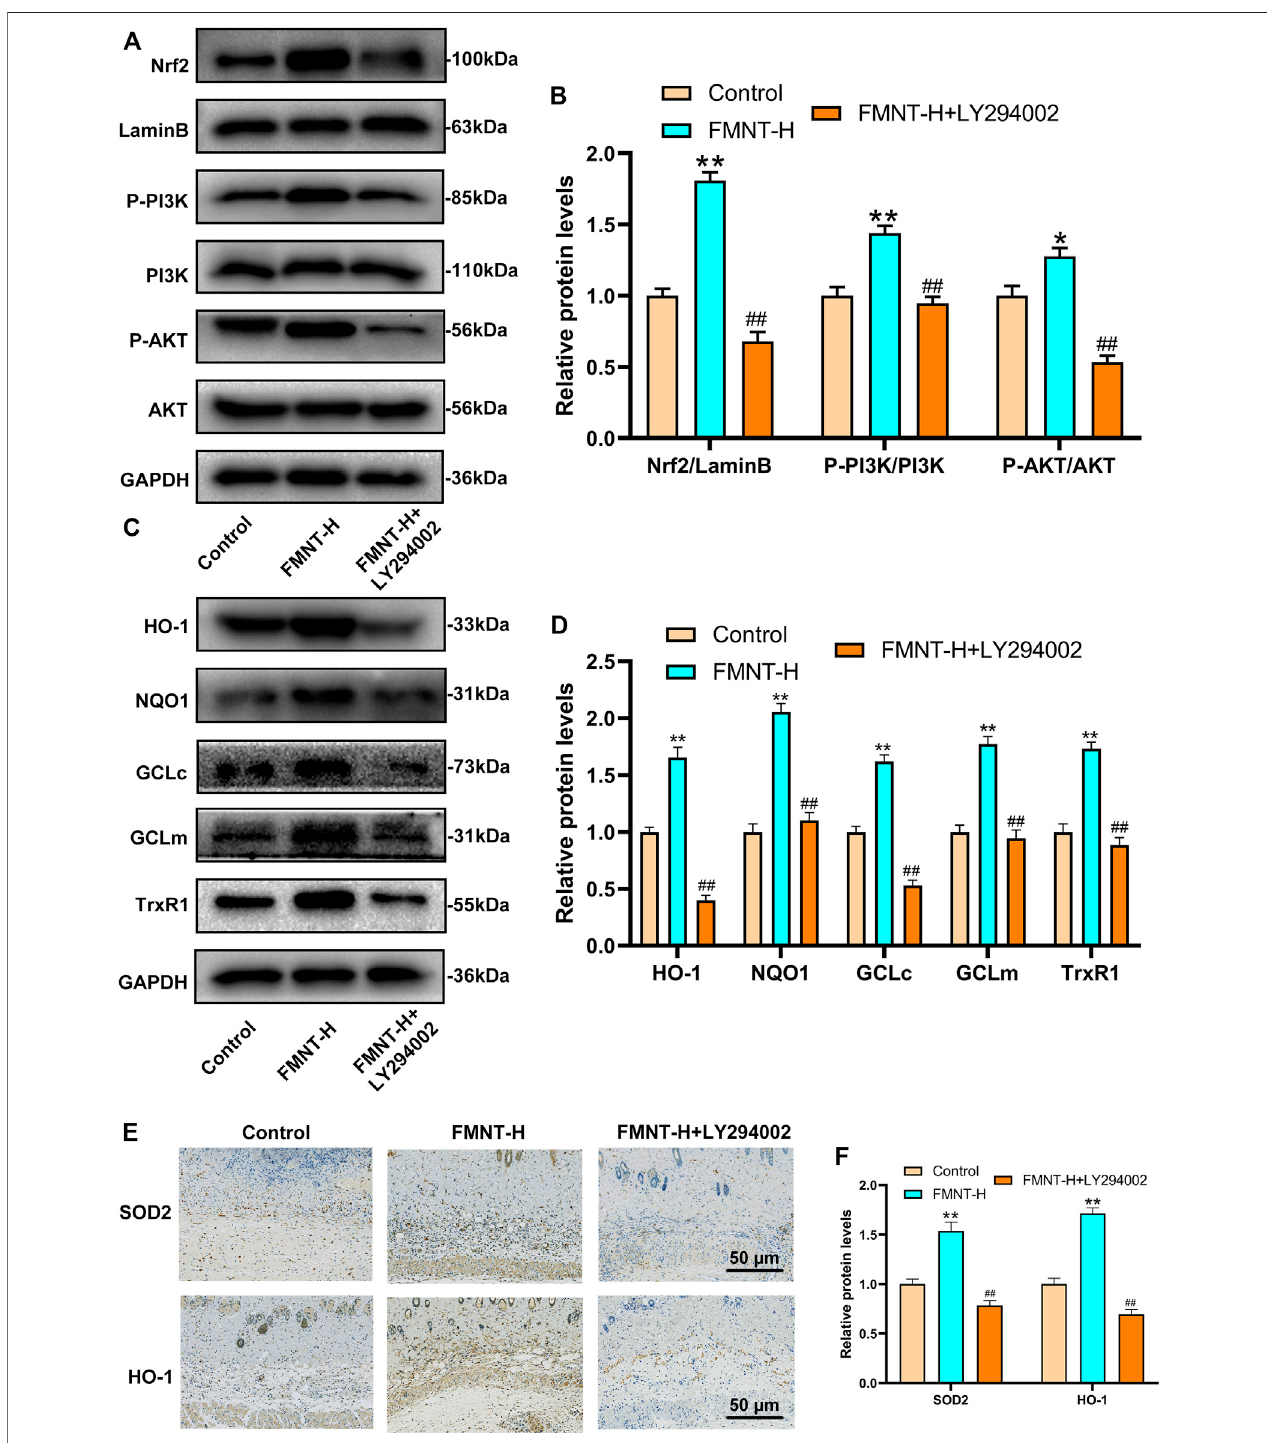
FIGURE 7 | (A,B) Western blot along with its quanti fi cation revealed that the level of P-PI3K, P-Akt and Nrf2 as treated above (C,D) Western blot along with its quanti fi cation revealed that the level of HO-1, NQO1, GCLc, GCLm and TrxR1 (E,F) The IHC result of SOD2 and HO-1 expression in skin fl aps (scale bar: 50 μ m) ** p ≤ 0.01 compared to the control group; ## p ≤ 0.01 compared to the FMNT-H group.